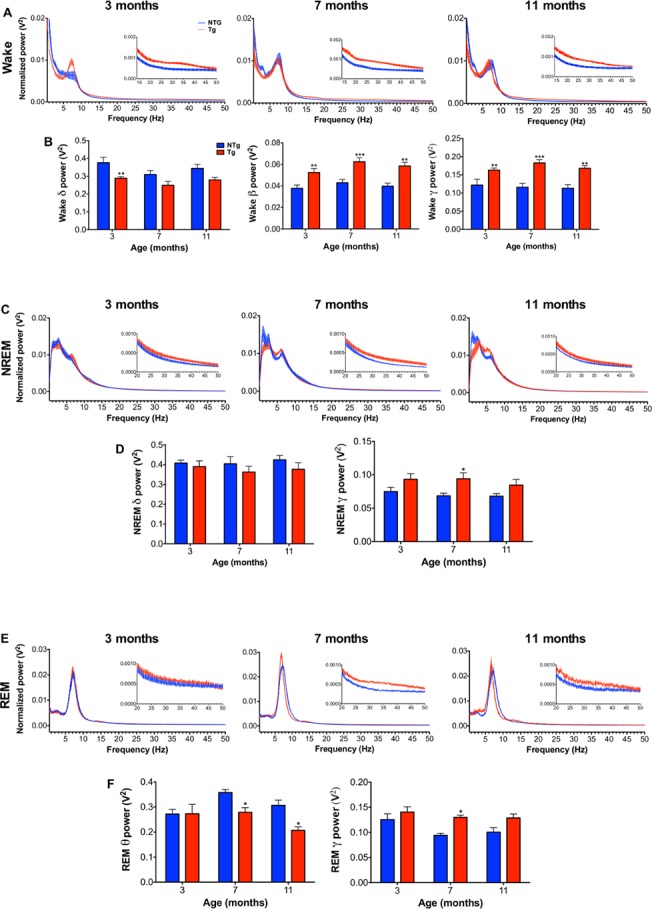
TgCRND8 mice show alterations in brain oscillatory activity during wakefulness, NREM and REM sleep.Normalized power spectrums from 0.125–50 Hz during wakefulness (A), NREM (C), and REM sleep (E), and normalized spectral power quantifications of key frequency bands during wakefulness (B), NREM (D) and REM sleep (F) at 3 (NTg n = 7, Tg n = 8), 7 (NTg n = 5, Tg n = 7) and 11 months (NTg n = 6, Tg n = 4). (A and B) During wakefulness, 3-month-old TgCRND8 show a reduction in delta power (0.5–4.5 Hz), and at all ages, higher beta (14–20 Hz) and low gamma power (20–50 Hz) in comparison to NTg. (C and D) at all ages studied, NREM sleep delta power (0.5–4.5 Hz) was preserved in TgCRND8 in comparison to NTg. Seven-month-old TgCRND8 mice showed higher NREM low gamma power (20–50 Hz) in comparison to NTg. (E and F) The REM sleep power spectrum was unaltered in 3-month-old TgCRND8 mice, while 7 and 11-month-old TgCRND8 showed reduced REM sleep theta power (7–10 Hz) in comparison to NTg. Seven-month-old TgCRND8 also show higher REM sleep low gamma power (20–50 Hz) in comparison to NTg. The data represented above include vigilance state spectral power analysis of the dark phase (i.e. active phase) for wakefulness and of the light phase (i.e. resting phase) for NREM and REM sleep. Error bars represent SEM. Two-way ANOVA, followed by Tukey’s post-hoc test. * P<0.05, ** P<0.01, *** P<0.001.